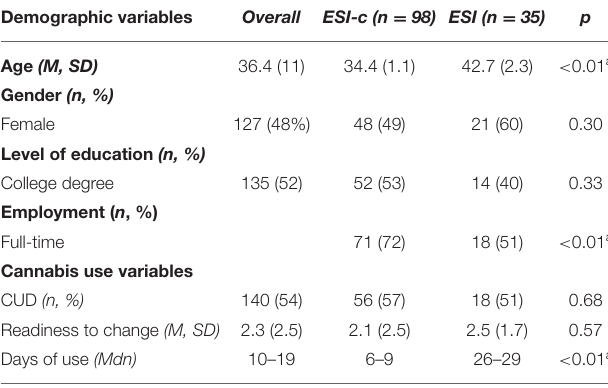
TABLE 1 | Demographic and participant